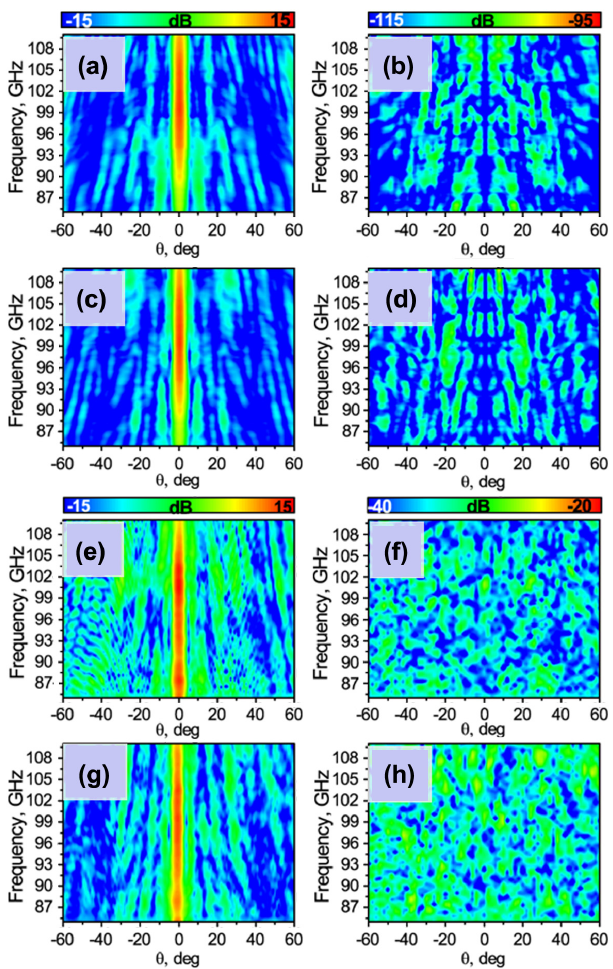
Figure 5. Numerical (a–d) experimental (e–h) radiation pattern of the WZP fishnet metalens antenna in the frequency range 85–110 GHz: co- (a, c, e, g) and cross-polarization (b, d, f, h). (a, b, e, f) E -plane and (c, d, g, h) H -plane.